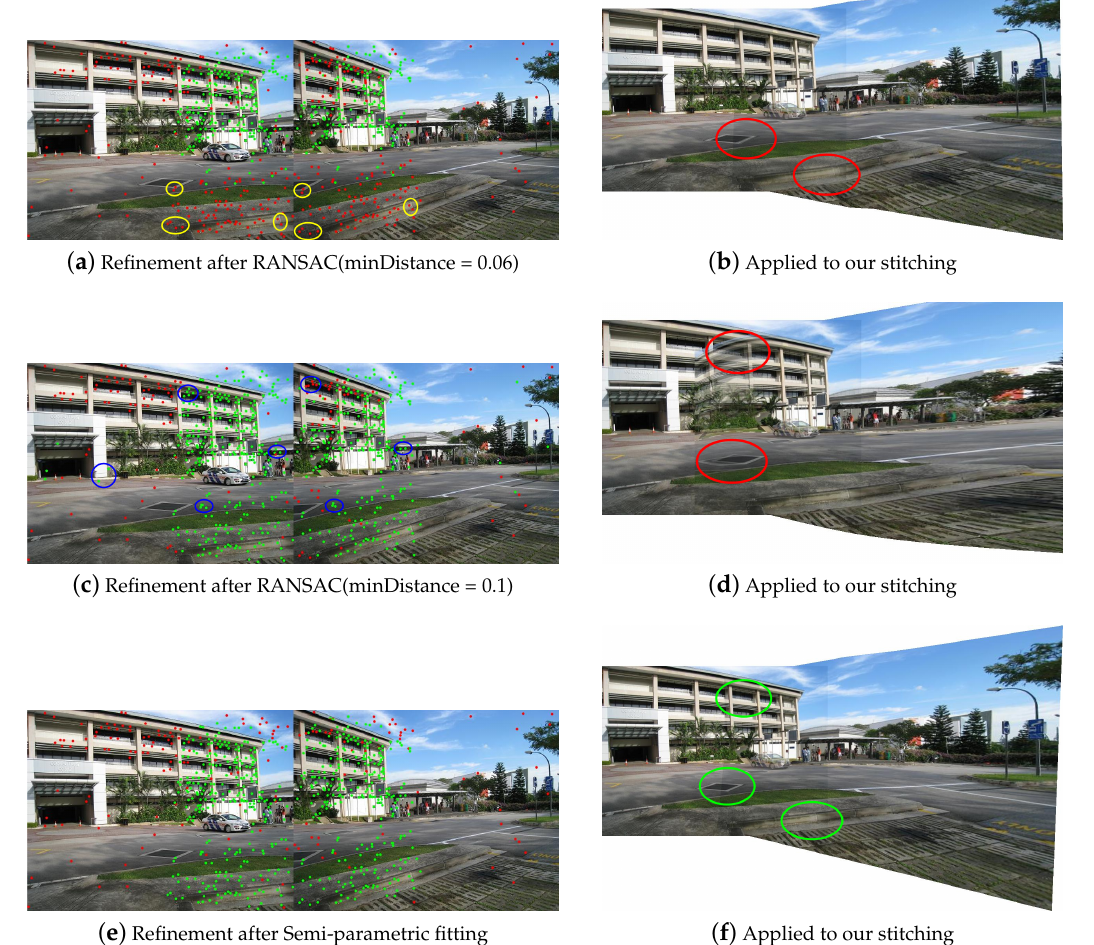
Figure 6. Feature match refinement. ( a , c ) are the outlier removal results of global RANSAC. The green dots and the red dots indicate the retained and removed features, respectively. Some of the removed inliers are marked in yellow, while the remaining outliers are marked in blue. ( b , d ) are the stitching results of our nonrigid warp based on the global RANSAC results. ( e ) is the feature refinement result of our semiparametric fitting. ( f ) is the stitching result of our